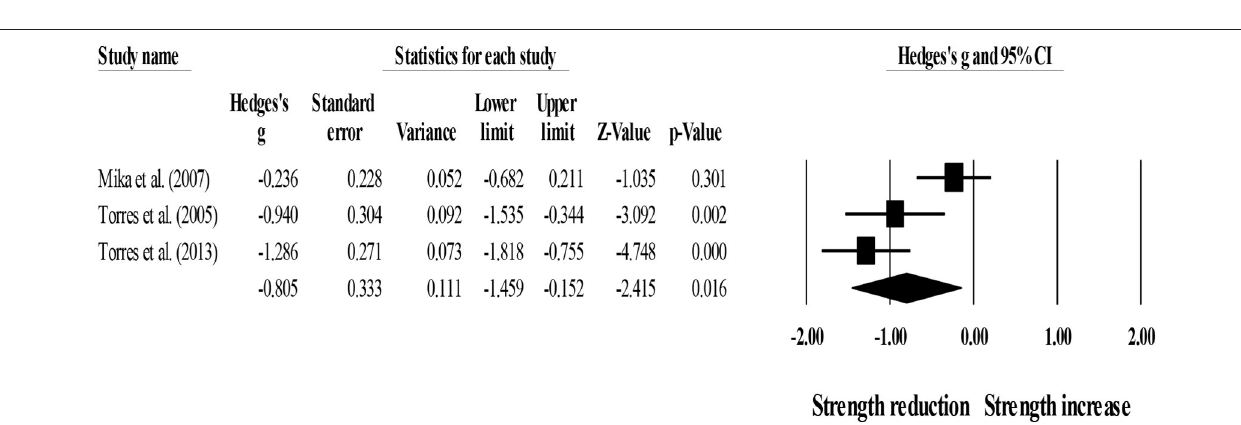
FIGURE 4 | Forest plot denoting short-term strength recovery level in participants that completed post-exercise passive recovery protocols. Values shown are effect sizes (Hedges’s g) with 95% confidence intervals (CI). The size of the plotted squares reflects the statistical weight of each study. The black diamond reflects the overall result. Note: negative values denote that post-exercise passive recovery protocols did not allow participants to recover their basal strength level (i.e., 0.00 in the